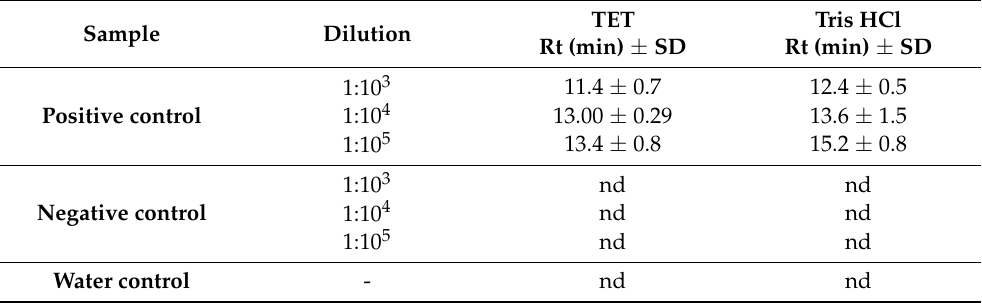
Table 6. Comparison of RT-LAMP assay on crude extracts prepared from mechanically inoculated plants at different dilutions in TET and Tris buffers. Experiment performed in the bCUBE instru- ment. Rt: reaction time; SD: standard deviation; nd: not detected.